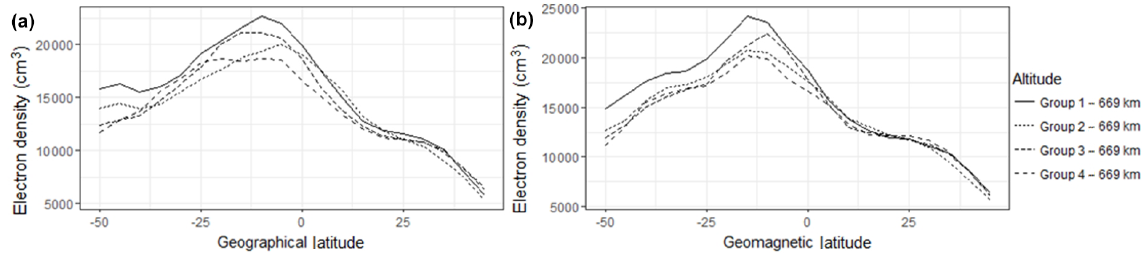
Figure 8. Variation in the ascending electron density with latitude, obtained using data for 2009.